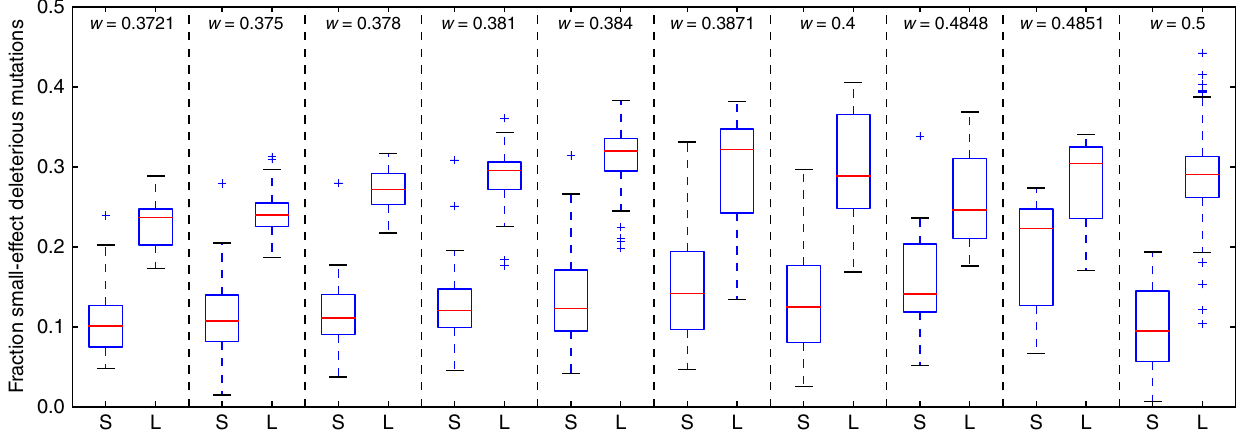
Fig. 6 Fraction of small-effect deleterious mutations for genotypes from small populations and large populations with equal fi tness. Each area separated by a dashed line shows genotypes with equal fi tness ( w ). S and L represent small-population and large-population genotypes, respectively. Differences for each fi tness value are signi fi cant. (Mann-Whitney U-test; Bonferroni-corrected p < 3 × 10 − 3 ). Box plots as described for Fig. w = 0.612 vs. median w = 0.611, Mann Whitney U = 4890.0, n = 100, p = 0.39 one-tailed; Fig. 4d).